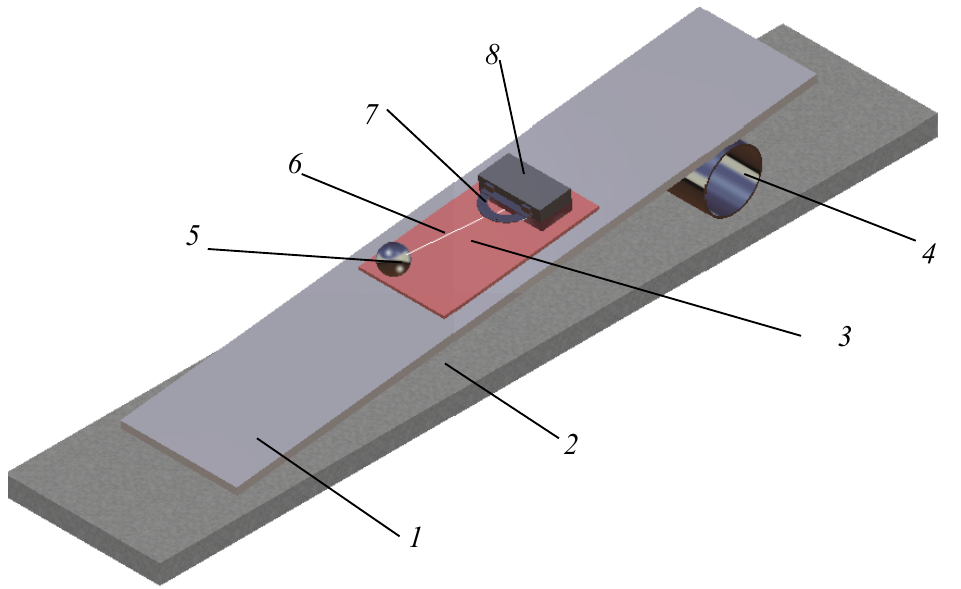
Figure 1. Scheme of the device.